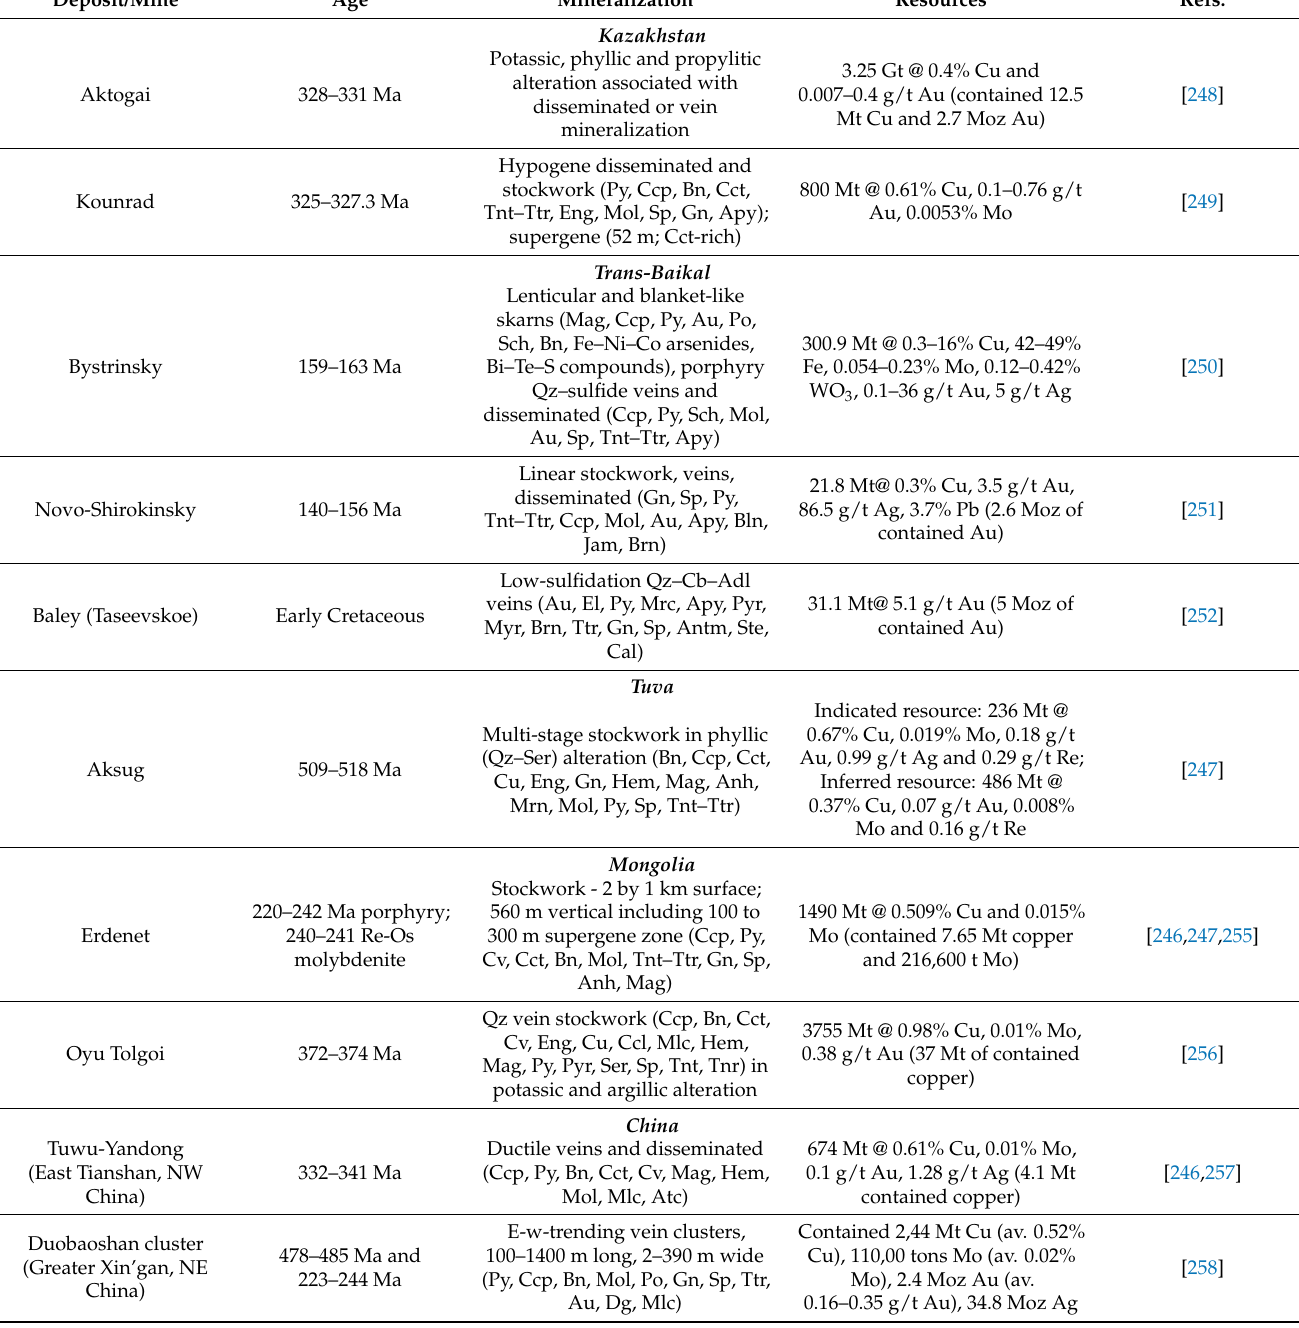
Table 10. Main characteristics of selected adakite-hosted Cu–Au deposits in the